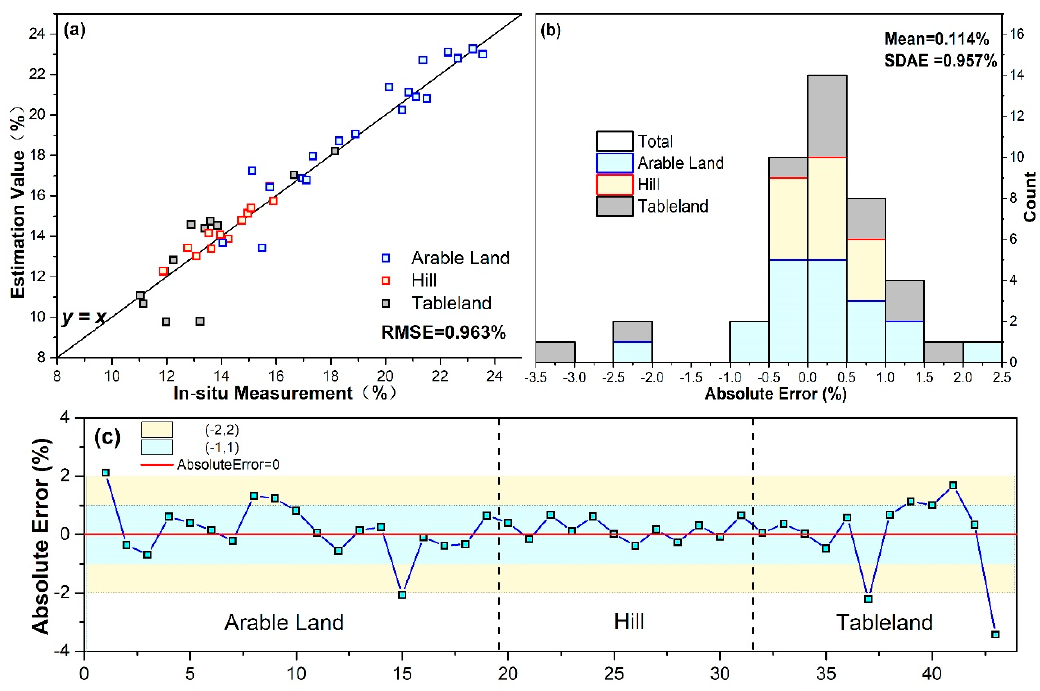
Table 3. The absolute errors statistic of soil moisture estimations on different topographical conditions.